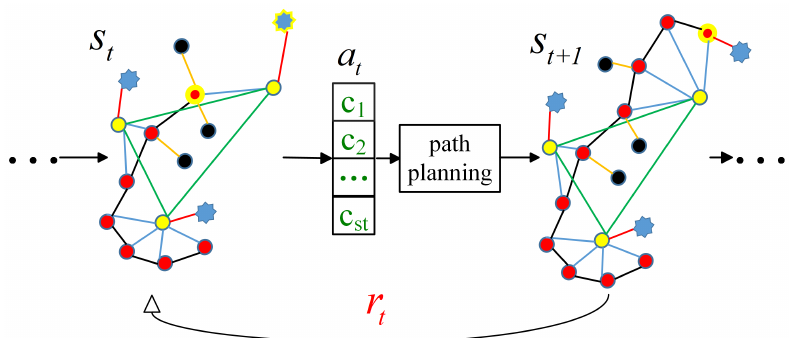
Figure 5. Extracting the exploration sequence. The exploration sequence consists of a series of exploration graphs, and each exploration graph represents a state. In the current state s t , if the robot takes the action a t to the next state s t + 1 , it will obtain the immediate reward r t